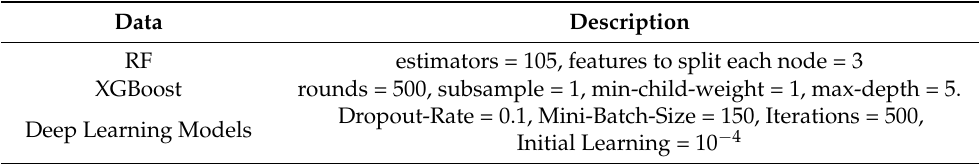
Table 2. Optimal values for the classifier parameters.